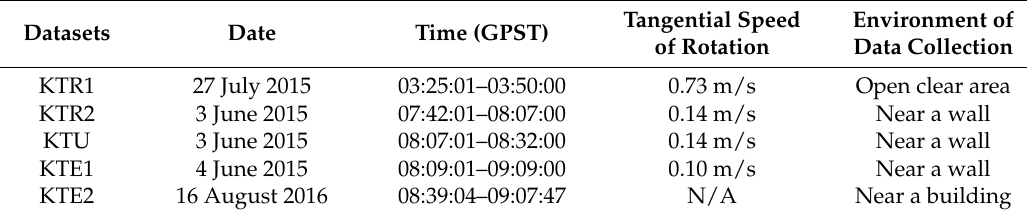
Figure 7: a base, a cabinet, a rotating arm, and two platforms. The base with a motor and a battery is at the bottom of the center. Above the base, there is a cabinet to place GPS receivers, and an antenna can